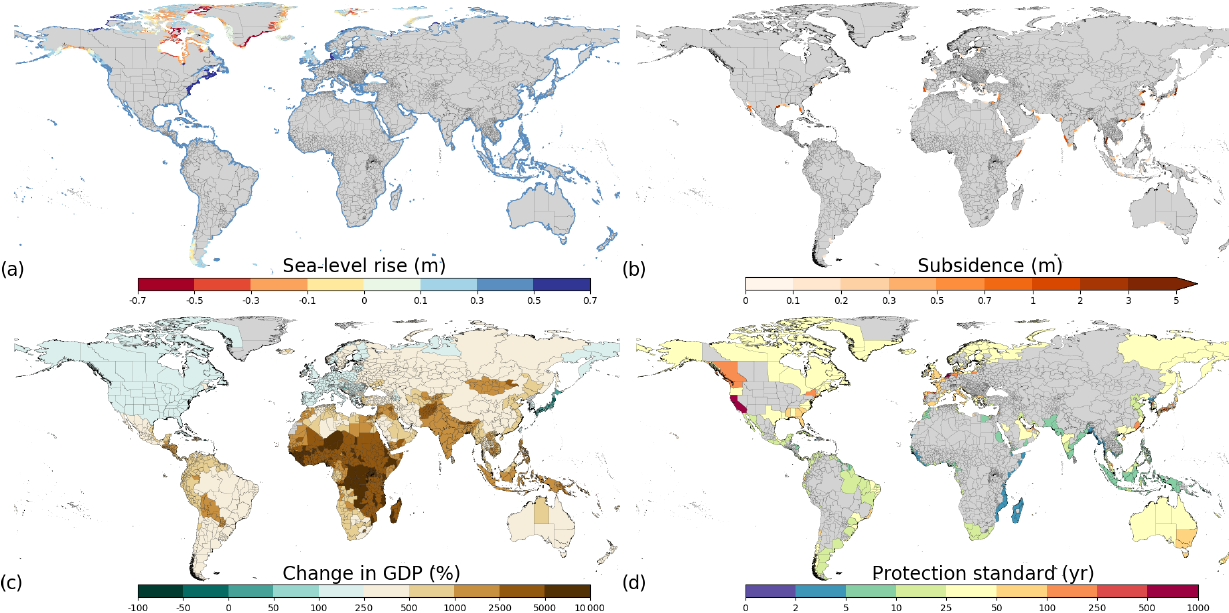
Figure 2. Input layers for the benefit–cost analyses: (a) sea-level rise for the RCP4.5 scenario in 2080, (b) subsidence in 2080, (c) change in GDP for the SSP2 scenario in 2080, and (d) current protection standards estimated with the FLOPROS modelling